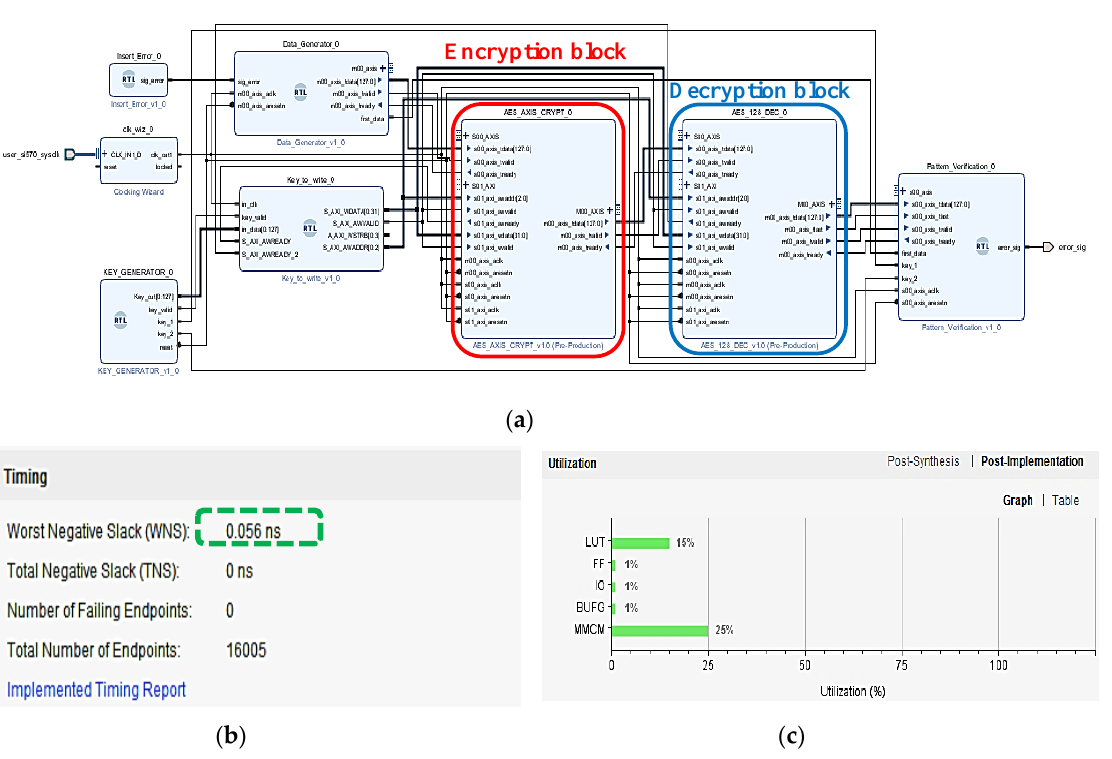
Figure 23. Block Design including the encryption (red box) and decryption (blue box) blocks connected in cascade ( a ); screenshot of Project Manager, obtained by post-implementation simulation, using a clock frequency of 220 MHz and Explore implementation strategy, showing the positive WNS parameter (green-dashed box) equal to 0.056 ns ( b ) and the hardware usage of the overall system ( c ).